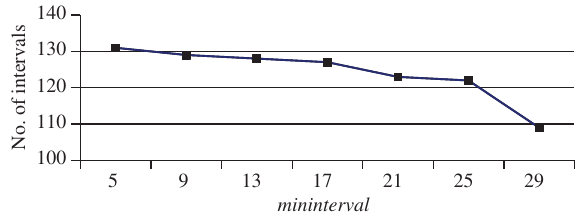
Figure 5. retail ( minsupp = 0.25, maxgap = 7).